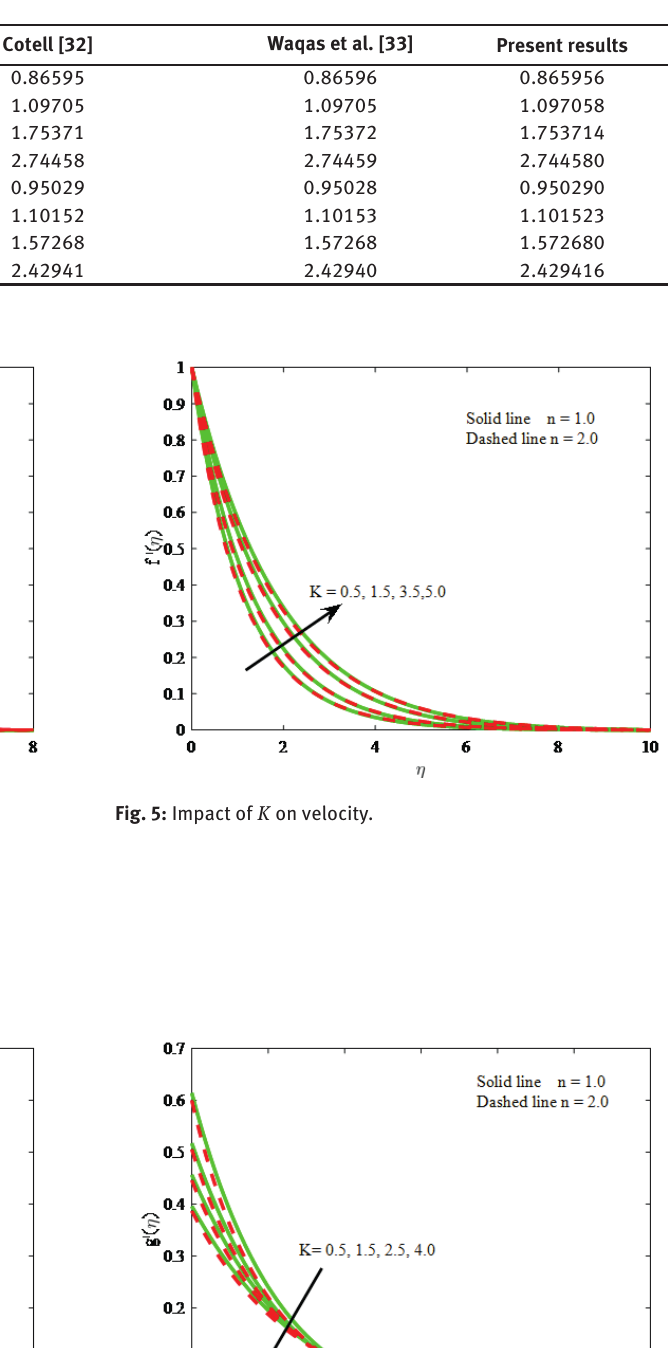
Table 1: Comparative of the present numerical results of − f (cid:3)(cid:3) (0) for the variations of n and M with the published literature when Pr = 0.7 , ϵ = 0 , and γ = 0 .